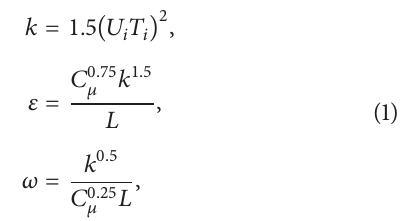
Figure 5: The time averaged, streamwise velocity component along the domain centerline ( −4.5 ≤ 𝑥/𝐷 ≤ 16 , 𝑦/𝐷 = 0.5 , 𝑧/𝐷 = 0 ) comparing the SKE, RNGKE, and the SSTKW turbulence closure models with the experiments performed by Lyn et al. [15, 16]. The SSTKW model with near wall resolution, 𝑦 + = 30 , resulted in the closest agreement with experiment.